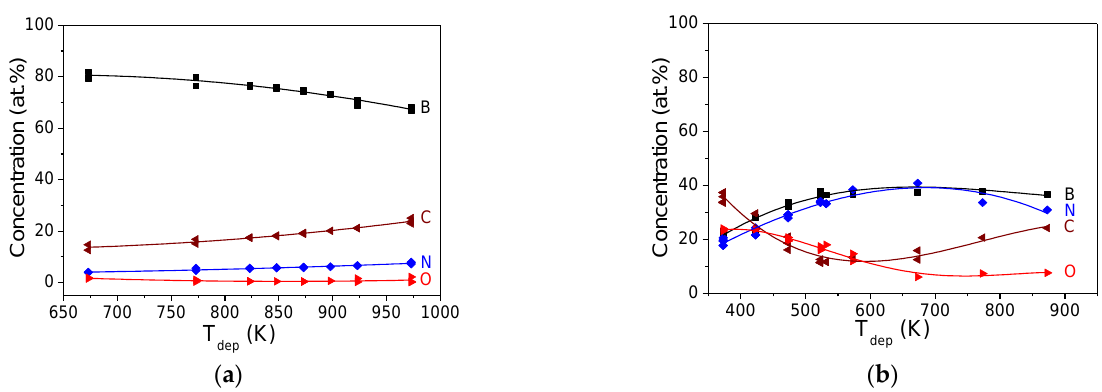
Figure 5. Temperature dependence of elemental composition of films obtained by ( a ) LPCVD and ( b ) PECVD methods using TMAB + N 2 mixture.